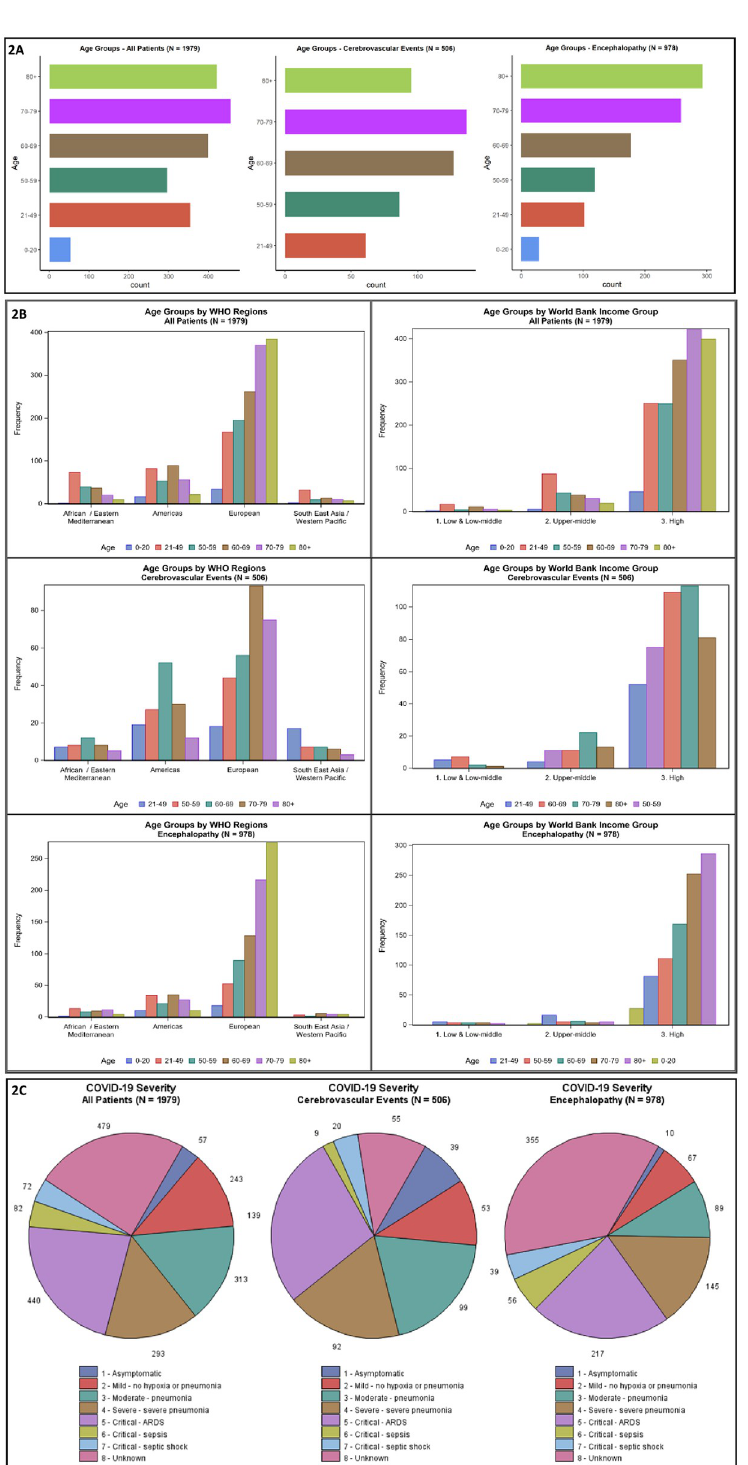
Fig 2. Characteristics of patients in the individual patient data (IPD) database.